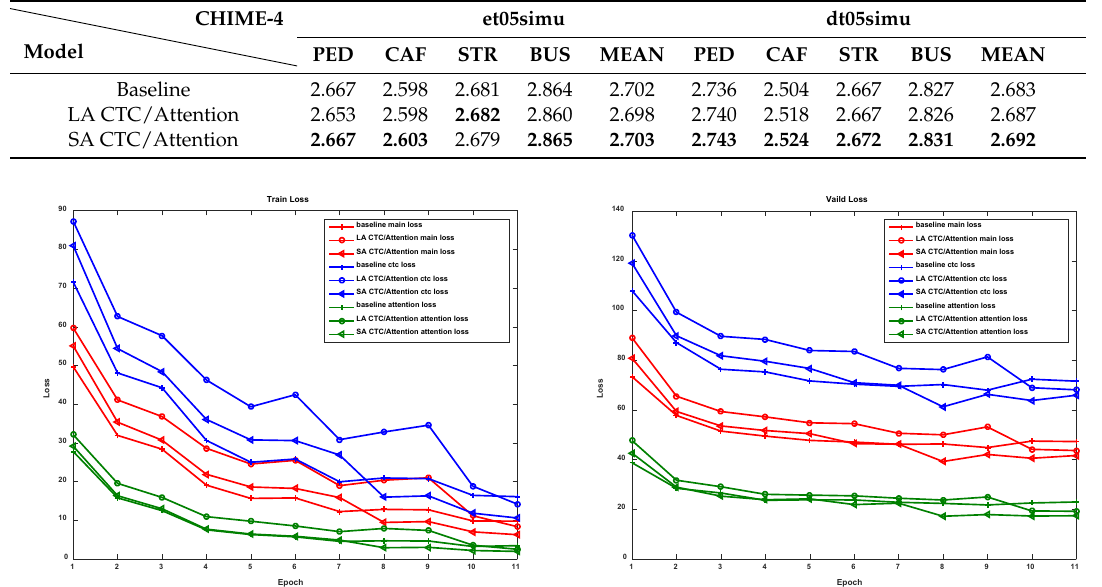
Table 5. The PESQ of the SA CTC/Attention for CHIME-4 compared with the LA CTC/Attention and baseline architectures.